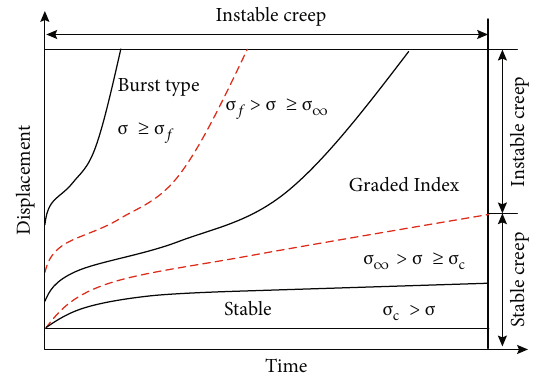
Figure 1: The curve type of slope displacement-time under di ff erent loading conditions, where σ is the stress of the slip body, σ c is the rock rheological limit, σ f is the instantaneous intensity.